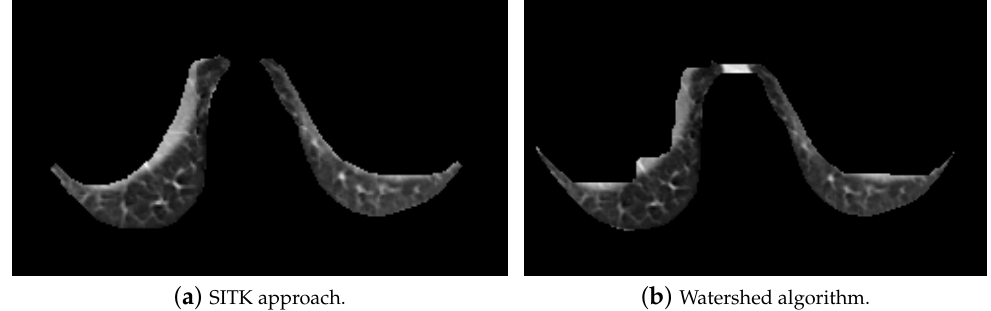
Figure 14. Segmented lungs in Slice No. 66 (end of the